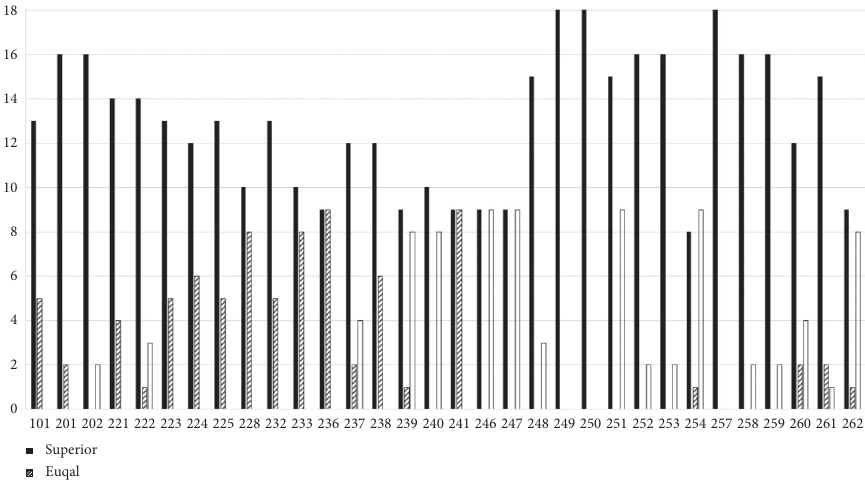
Figure 9: The number of participants with ECGA-OEM superior, equal, and